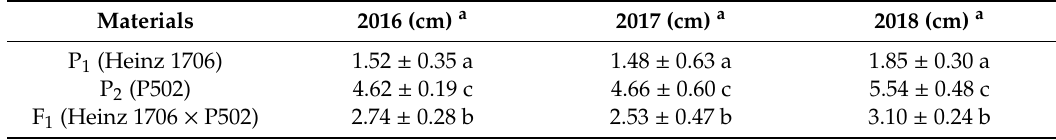
Figure 3. Internode length frequency distribution of F 2 individuals at 40-day-old seedlings. ( a ) 2016 ( n = 140). ( b ) 2017 ( n = 400). ( c ) 2018 ( n = 354). The mean internode lengths were recorded from the first internode to the fifth internode (starting from the cotyledons). Table 1. Internode lengths of P 1 , P 2 , and F 1 population plants.